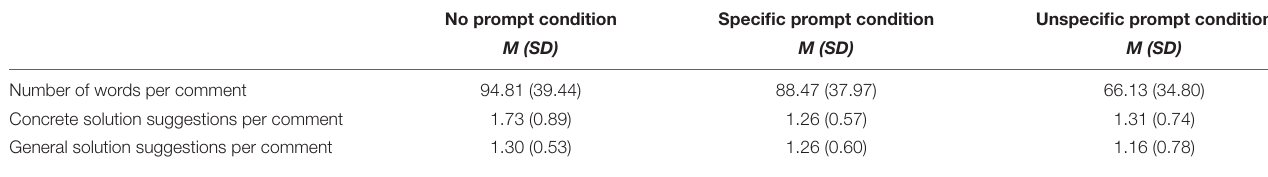
TABLE 2 | Comprehensiveness of comments and concrete and general advice in the three conditions in Study